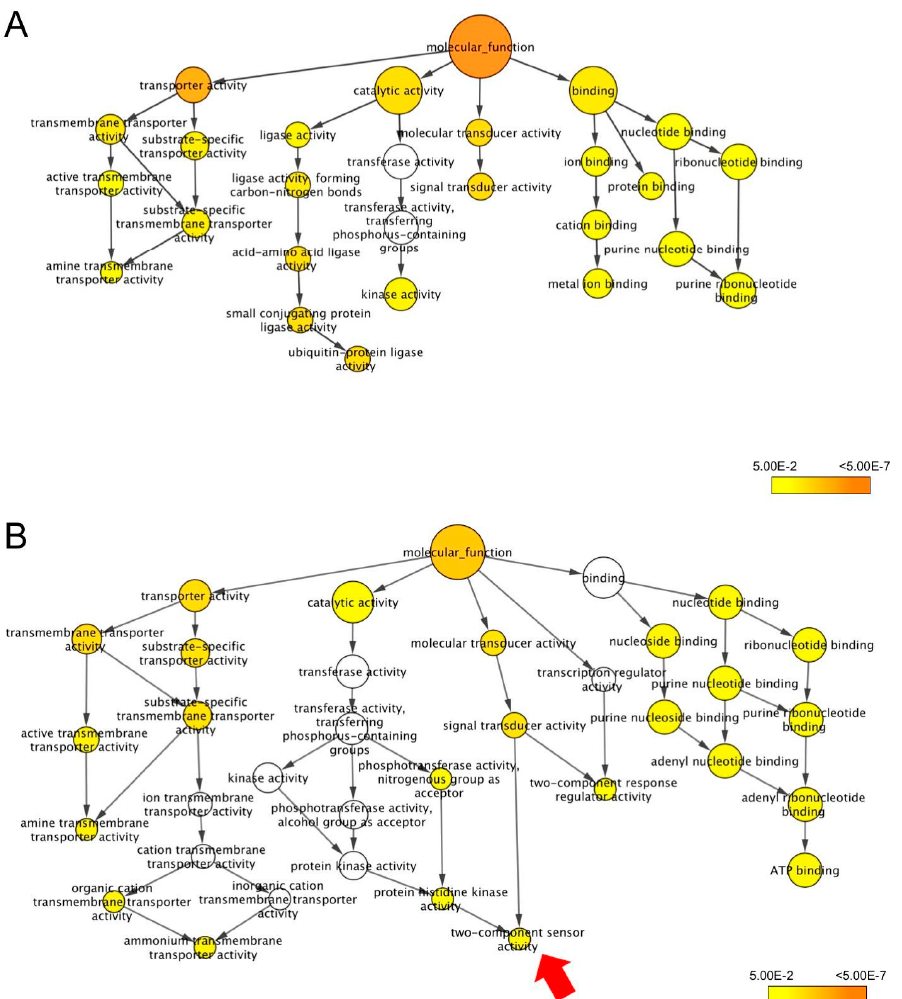
Figure 7. Molecular function GO terms enriched for the differentially expressed genes (DEGs) in ‘KDML105’ ( A ) and CSSL18 ( B ) by BiNGO. The red arrow indicates a term enriched only for CSSL18 DEGs .